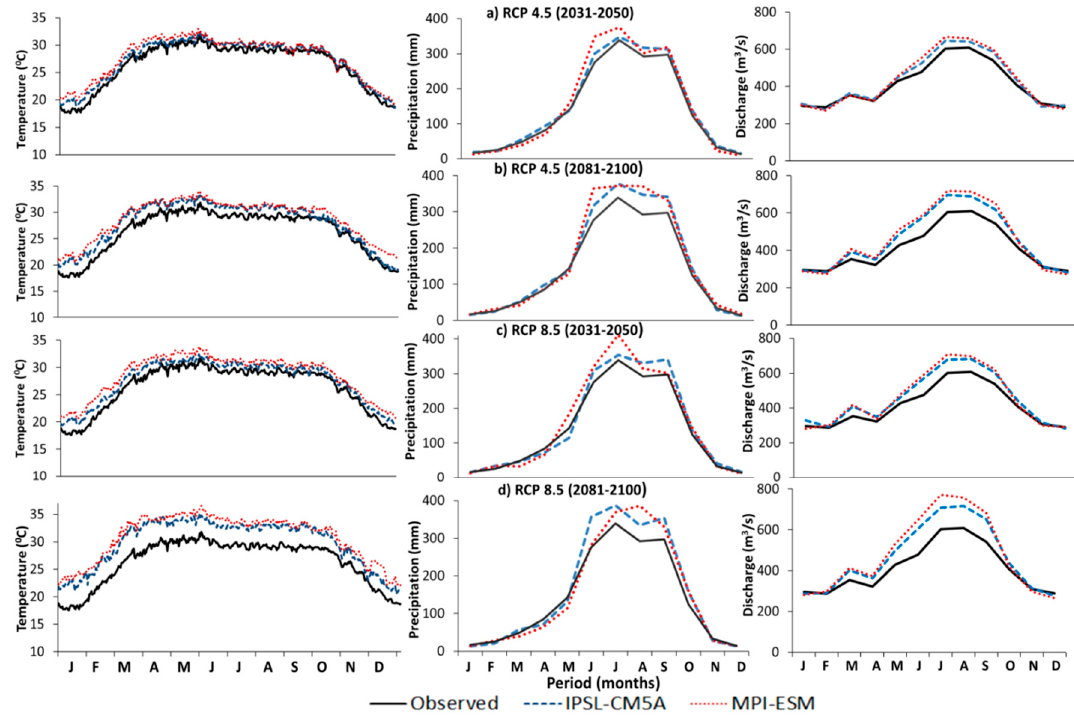
Figure 5. Daily average air temperature (left), monthly average precipitation (middle), and monthly average discharge (right) projections for the Betna River basin for two RCPs, RCP 4.5 ( a , b ) and RCP 8.5 ( c , d ) and two future periods, near future (2031–2050; a , c ) and far future (2081–2100; b , d ).